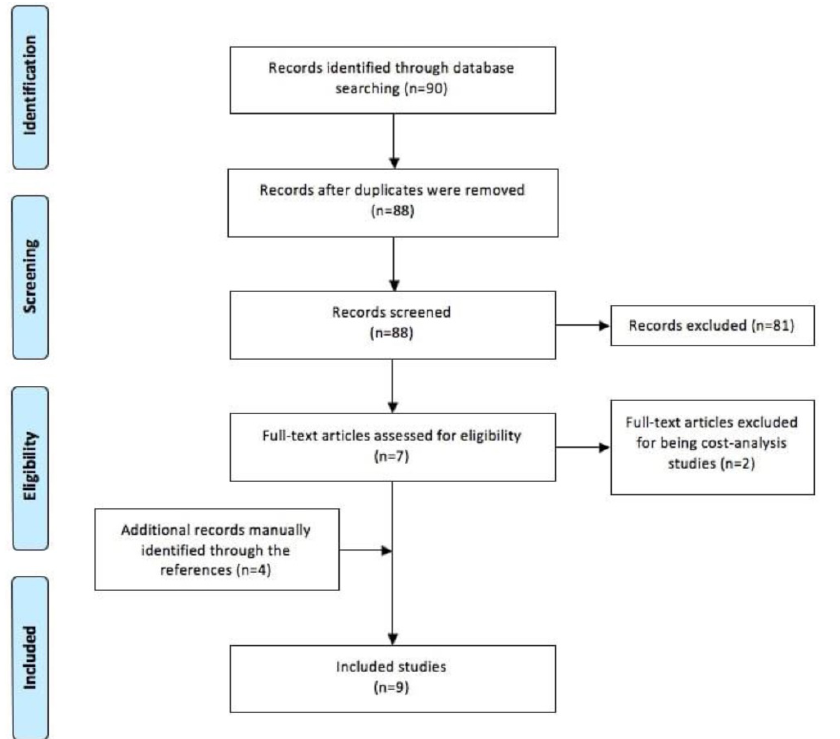
Figure 1. Flow diagram showing the systematic review process used in this